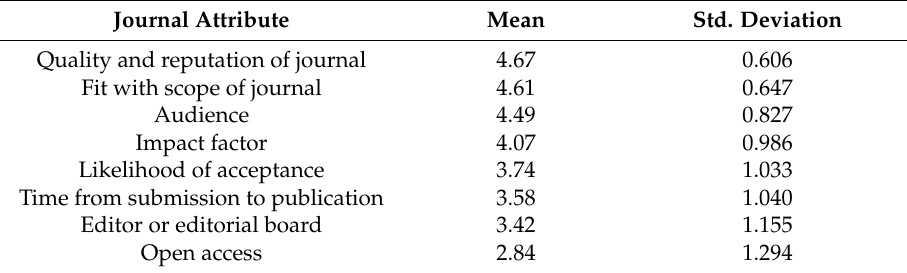
Table 3. Importance of journal